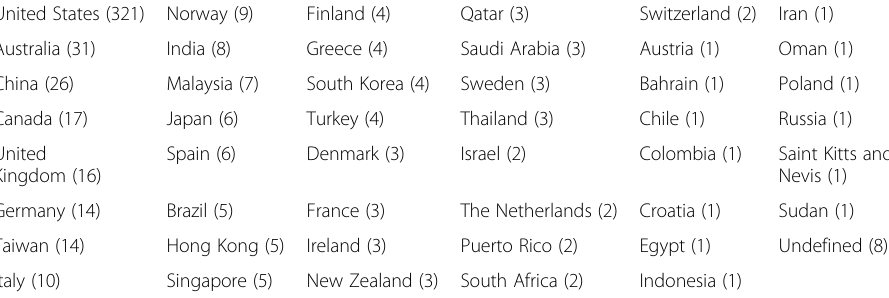
Table 1 Publications by country of first-author